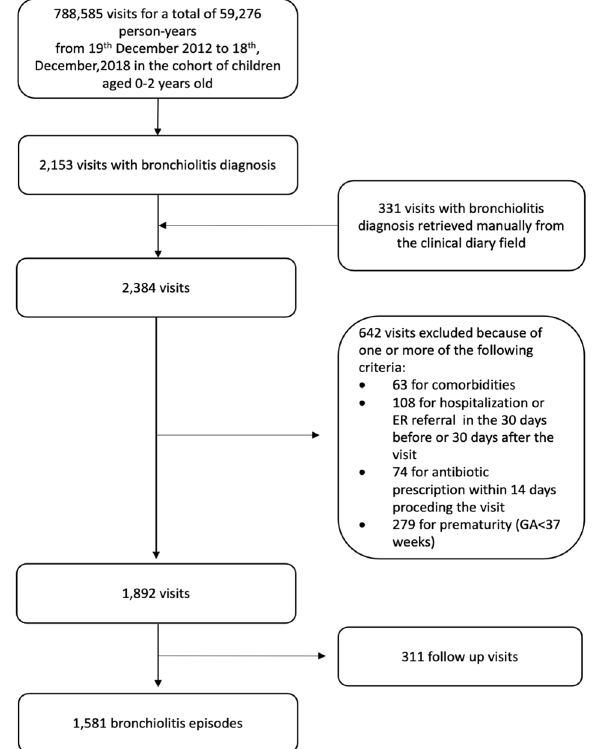
Fig. 1 Bronchiolitis episodes ’ inclusion fl ow chart (Pedianet, 2012 – 2018). ER emergency room, GA gestational